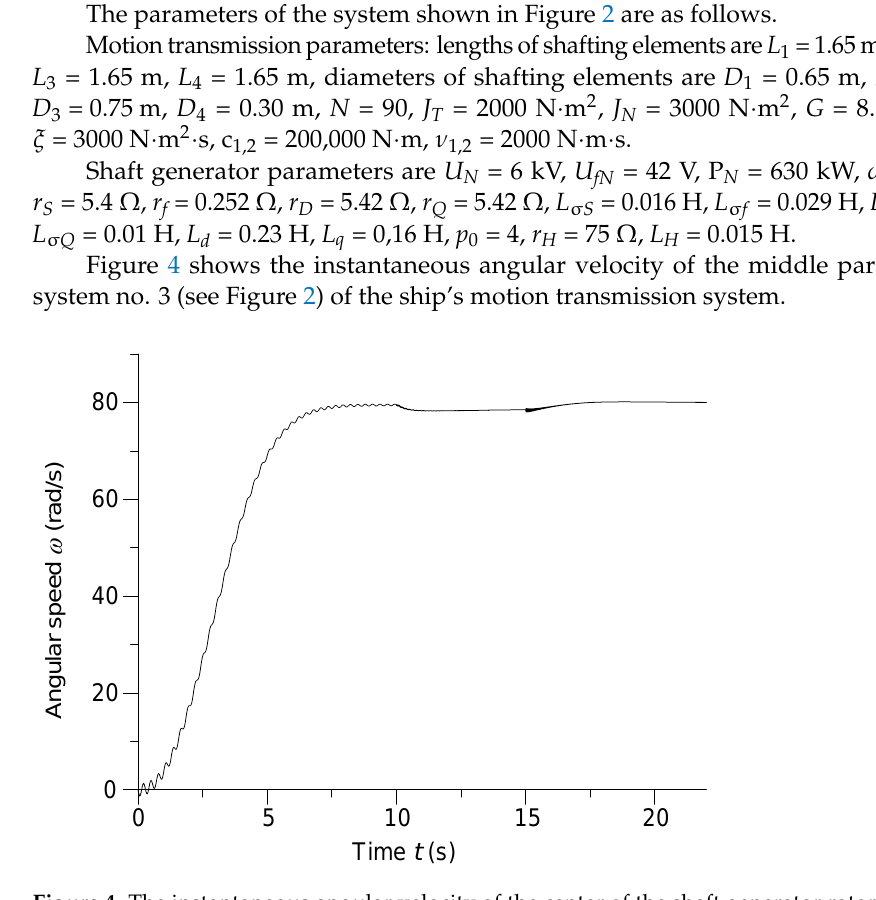
Figure 4. The instantaneous angular velocity of the center of the shaft generator rotor.